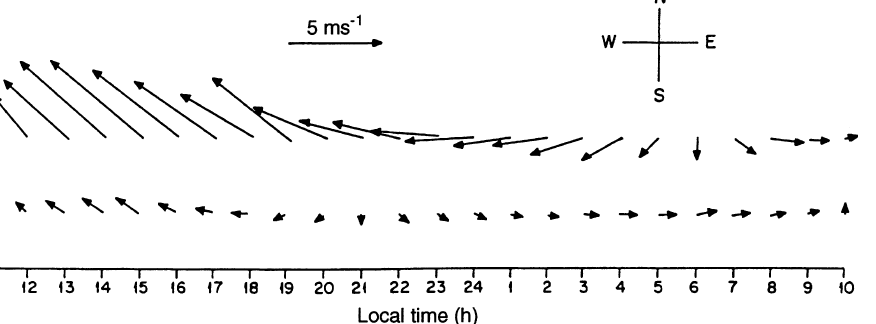
Fig. 14a,b. Simulated and observed diurnal variation of the sea- breeze for an upwelling case: a simulated values for OND, at 990 hPa, at a grid point situated inland 10 km from both the SN and EW coastlines (point E in Fig. 1); and b observed values (10 m above